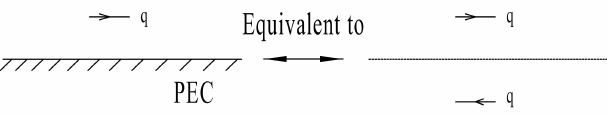
Figure 10. Schematic diagram of image